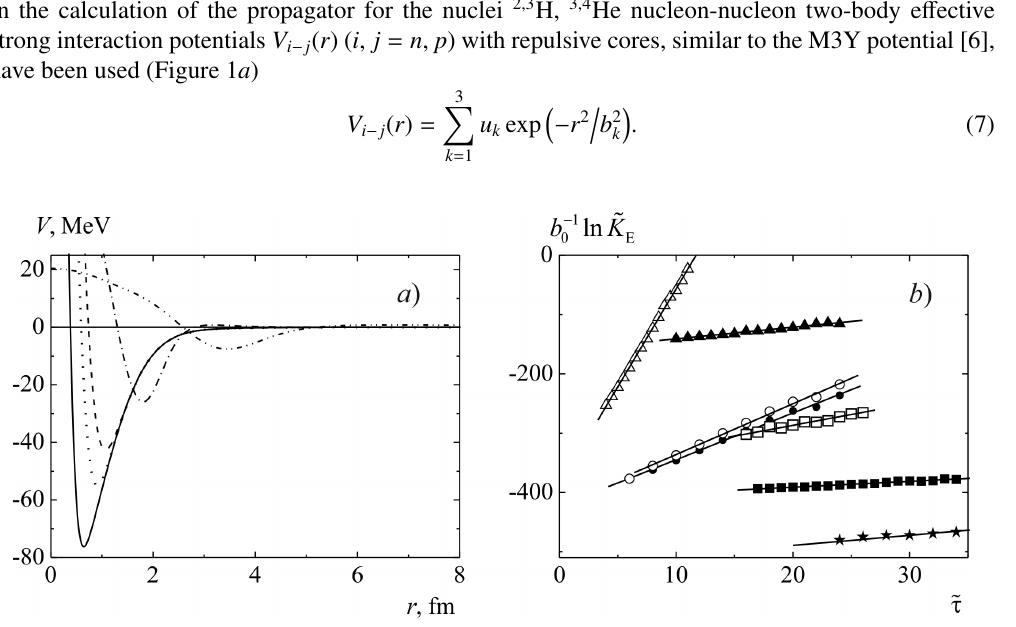
Figure 1. a ) Two-body interaction potentials V i j ( r ) for the following pairs of particles: neutron-proton with − parallel (solid line) and antiparallel spins (dotted line), neutron-neutron (dashed line), α -cluster-neutron (dash- dotted line) and α -cluster- α -cluster (dash-dot-dotted line). b ) The dependence of the logarithm of the dimension- less propagator ˜ K E on the dimensionless Euclidean time ˜ τ for 2 H (filled triangles), 3 H (circles), 3 He (dots), 4 He (empty triangles), 6 He (filled squares), 6 Li (empty squares), 9 Be (stars); lines are the results of linear fitting of the data; b 0 is a coe ffi cient